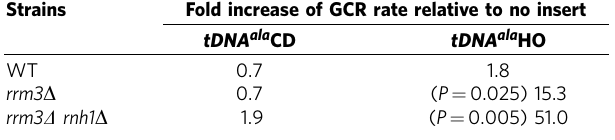
Table 2 | Fold increase of GCR rate relative to no tDNA